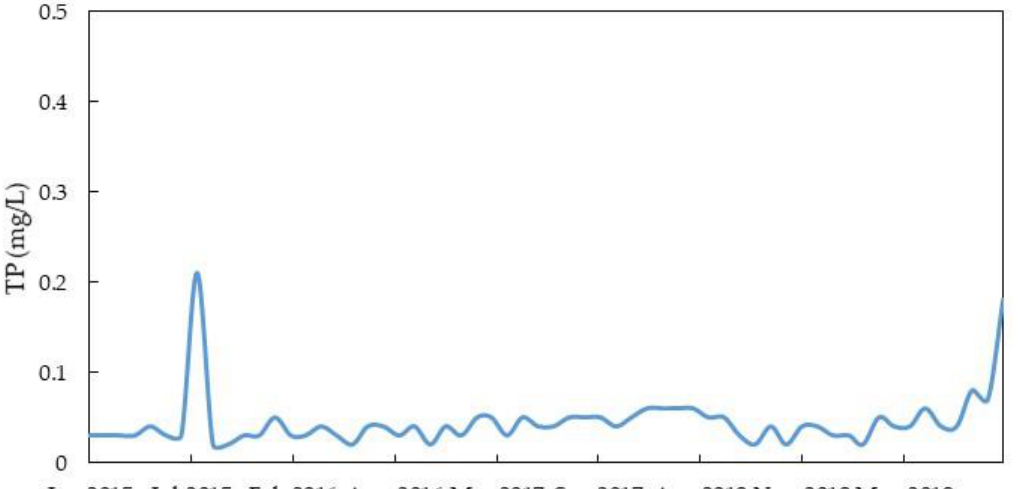
Figure 10. Annual TN concentrations in the Hongfenghu reservoir watershed from 2015 to 2019.